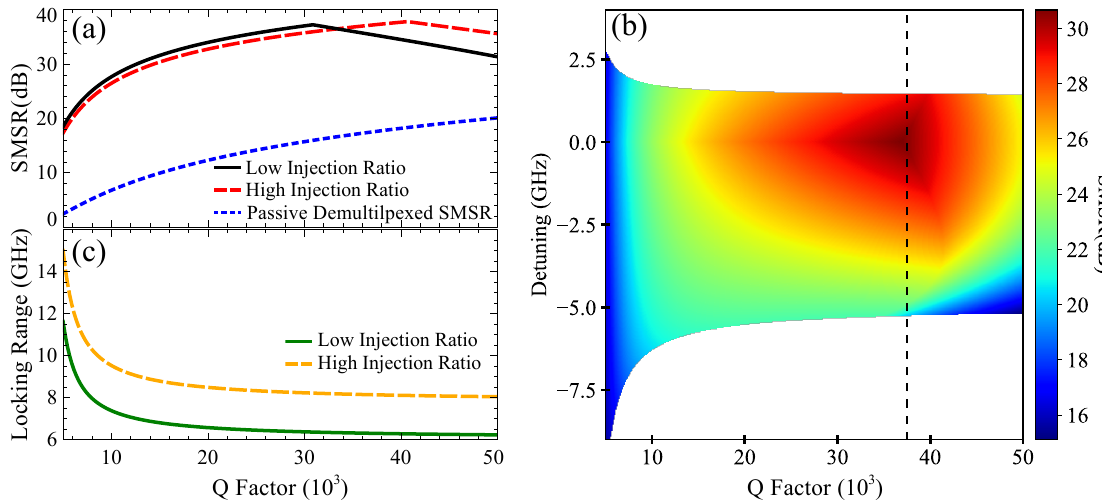
Figure 8. Calculated results from optical comb injection simulations, of a 700- µ m FP laser. ( a ) Plot showing how the SMSR of the output spectrum varies as the Q of the laser cavity increases, for two different injection ratios, assuming zero detuning and biased at 3.0-times the threshold. The higher injection ratio was initialised at 16.9 × 10 − 3 and the corresponding lower injection ratio at 10.1 × 10 − 3 . For qualitative comparison, the side mode suppression ratio (SMSR) from a passive cavity with equivalent Q is also plotted. ( b ) Intensity plot of how SMSR varies versus detuning and the Q factor, for an injection ratio of 6.7 × 10 − 3 , at a current of 2.5-times the threshold. The white regions indicate where the slave laser was unlocked. ( c ) Plot of the locking range of the FP laser versus Q, for the same injection ratios and parameters as in ( a